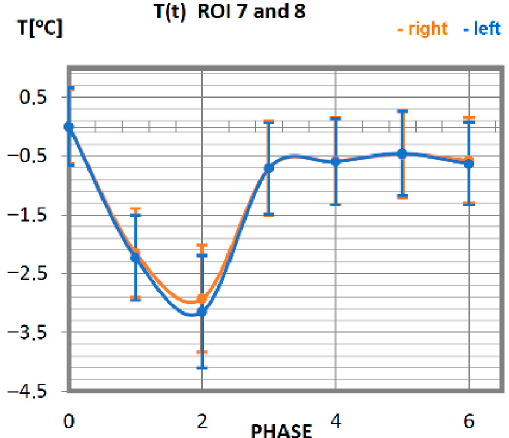
shown in Figure 5. The minimum temperature was recorded in the measurement taken